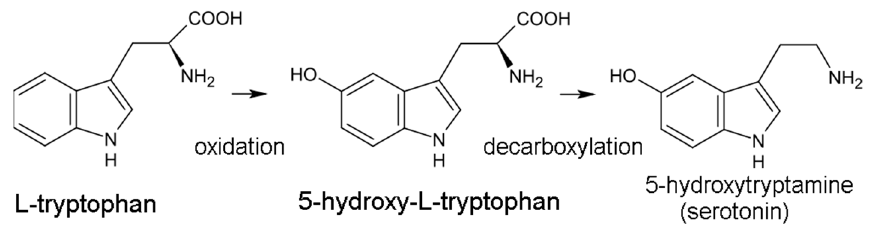
Figure 1. Conversion of tryptophan to